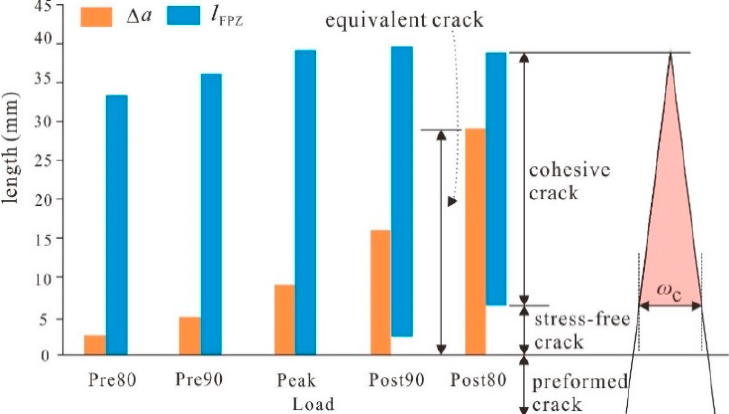
Figure 13. The propagation of FPZ and Δ a for specimen 0.3-3.